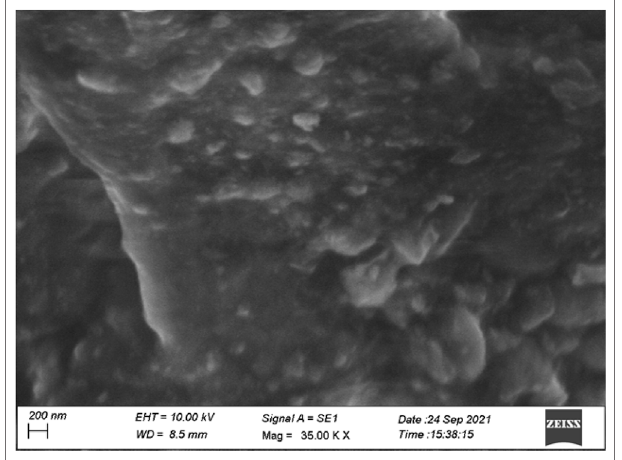
Data representthe mean ± standard deviation(SD)ofthe mean valuesof threeseparate